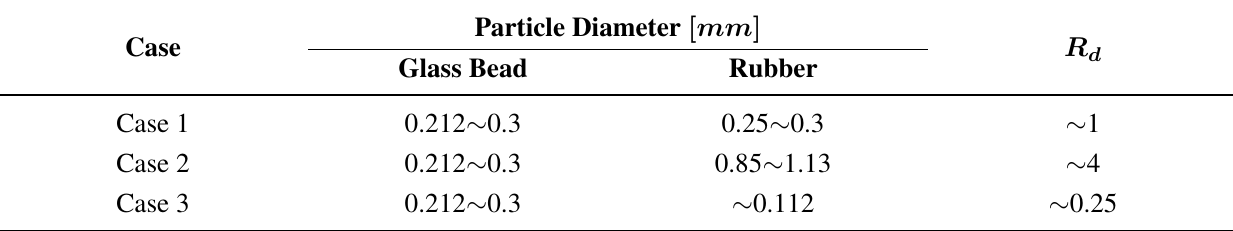
Table 1. Cases in glass bead-rubber mixture